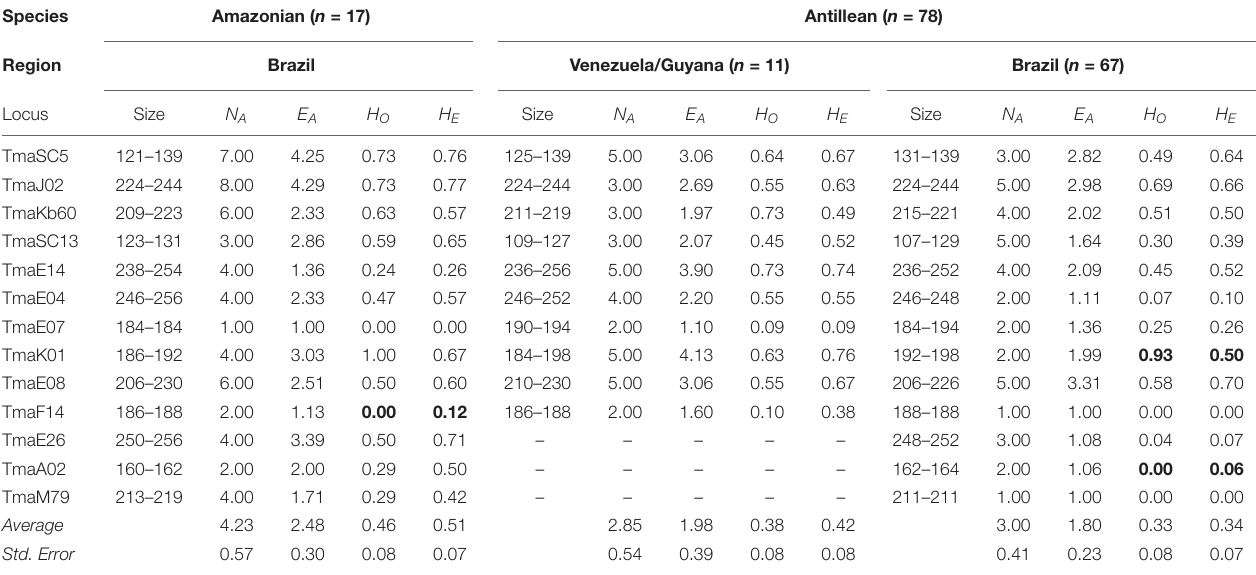
TABLE 1 | Amazonian and Antillean manatee summary statistics for the genetically identified clusters using 13 microsatellite loci. Number of alleles ( N A ), effective number of alleles ( E A ), observed heterozygosity ( H O ), and expected heterozygosity ( H E ) are displayed. Species Amazonian ( n = 17) Region Brazil